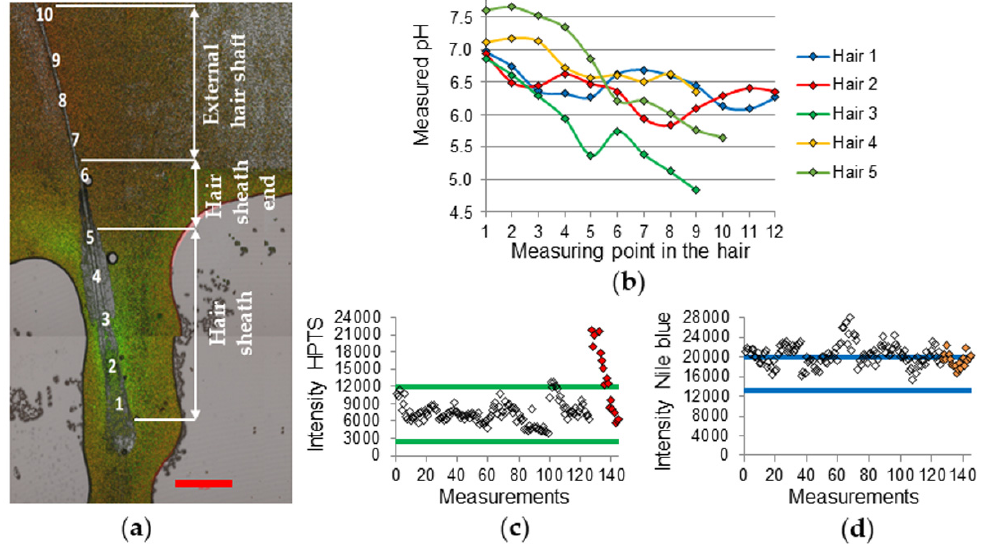
Figure 4. ( a ) CLSM fluorescence overlay of HPTS (green) and Nile blue (red) emission and transmission channels (subject 3, hair 5). Measurement points 1-10. Scale bar: 500 µm. ( b ) pH gradients of the different hairs from subject 3, measurement starts at the hair sheath (points 1–5), then at the infundibulum region (point 6) and ends at the external hair shaft (points 7–10). HPTS emission intensity raw data points of all hair measurements (hair 5 data points are filled) of subject 3 ( c ), Nile blue emission intensity raw data points of all hair measurements (hair 5 data points are filled) of subject 3 ( d ).